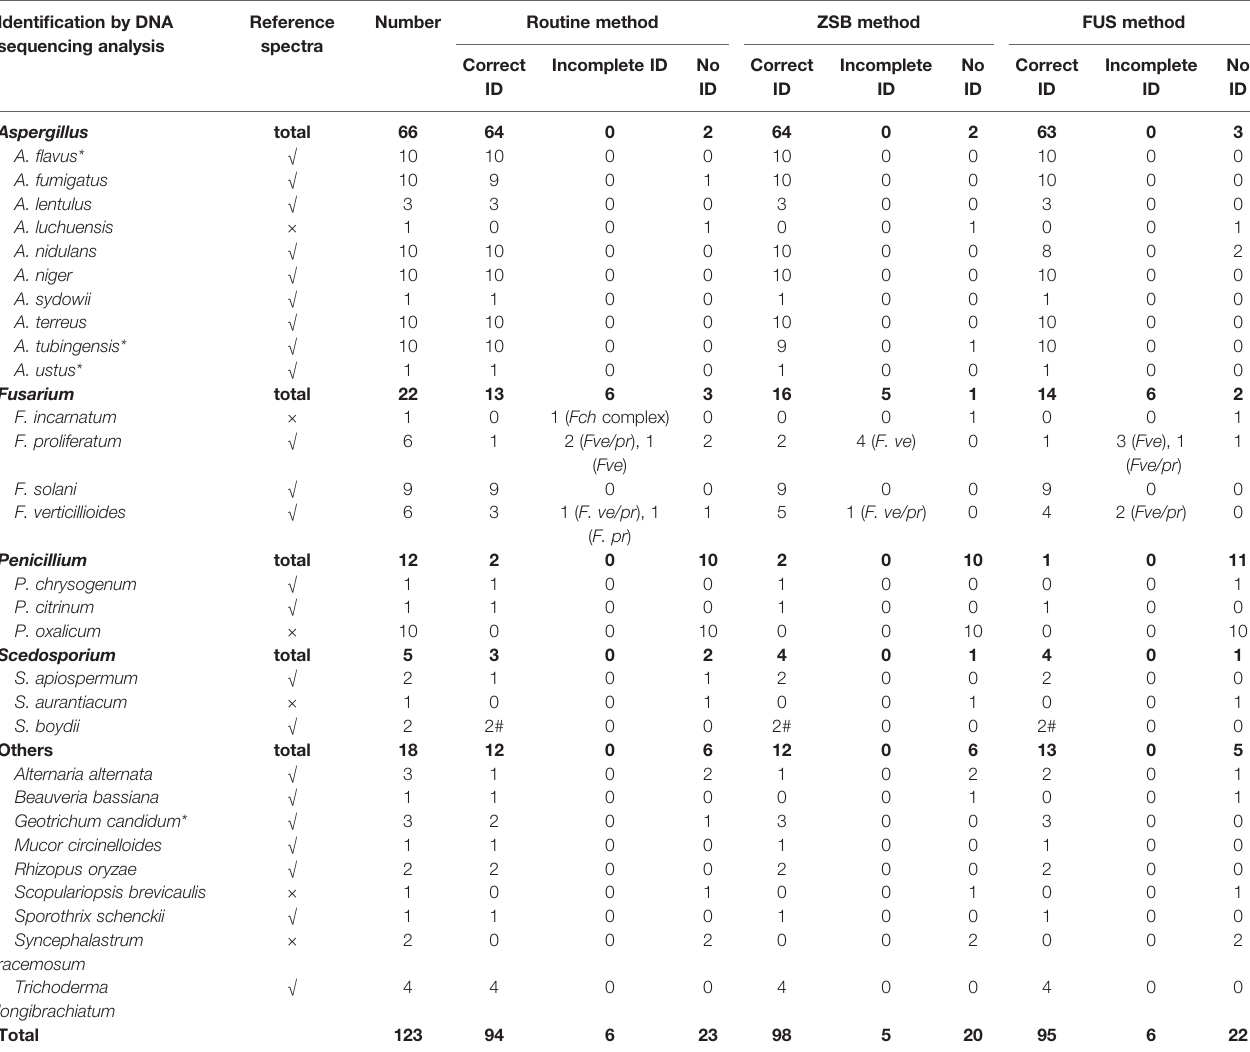
Identi fi cation by DNA sequencing